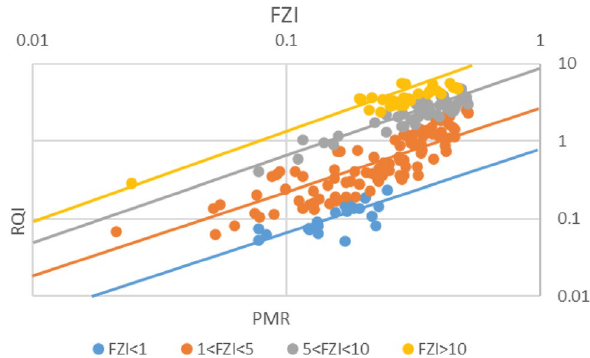
Fig. 6 RQI diagram in 𝜑 Z for all sampled